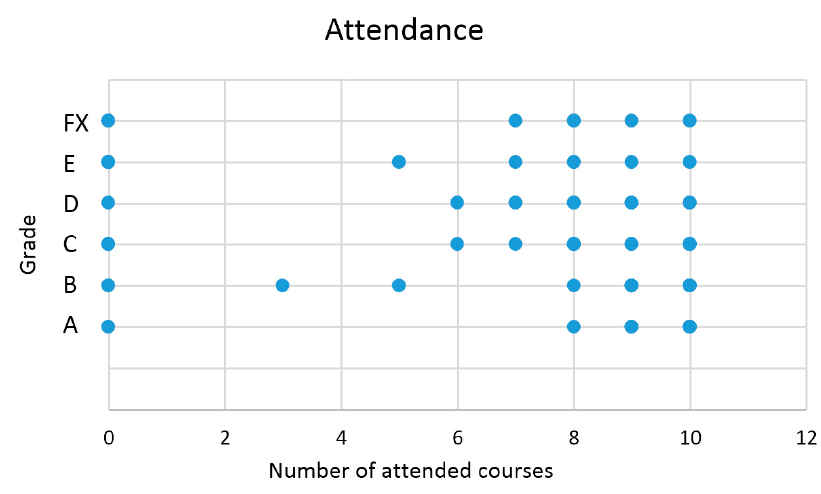
Figure 10. Grades based on attendance.